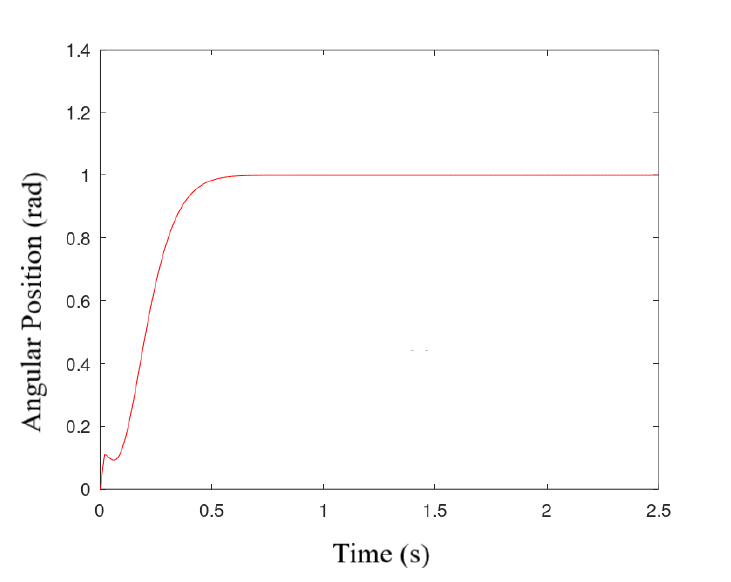
Figure 13. Rigid joint simulated controller.